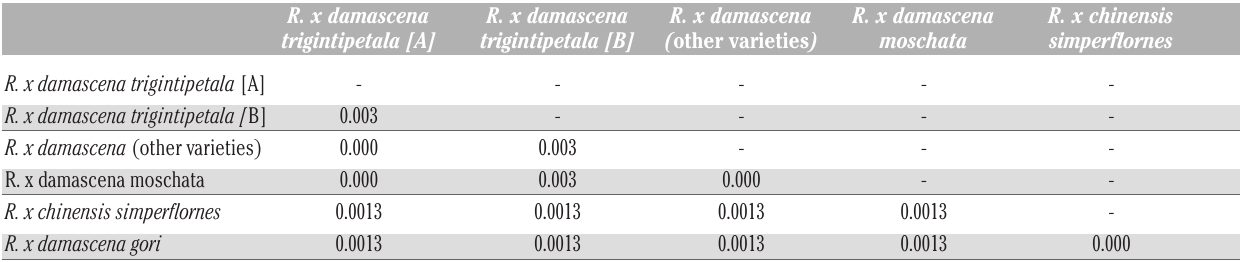
Table 1. Pairwise genetic distances among the different varieties of R. damascena populations. The distances were calculated from matK data sequenced in this study.